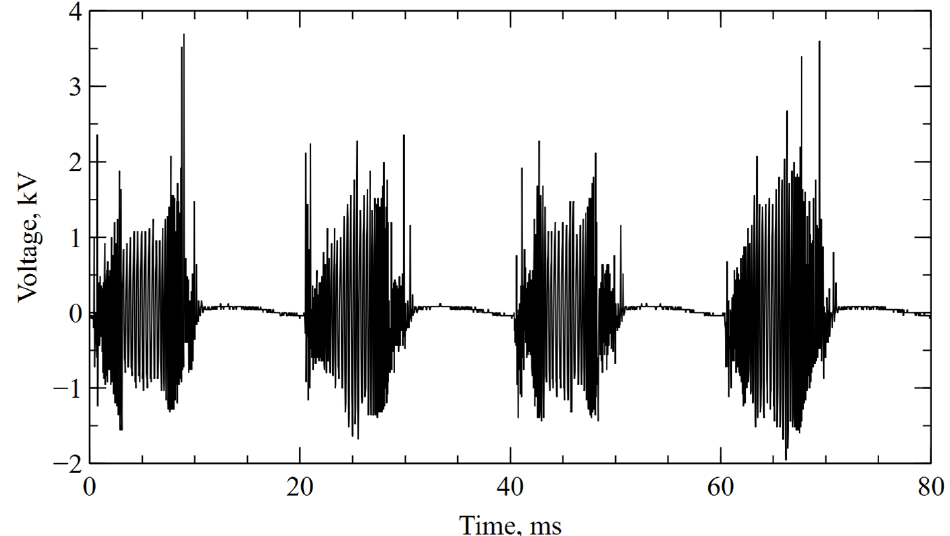
Figure 1. Voltage between electrodes during plasma treatment.